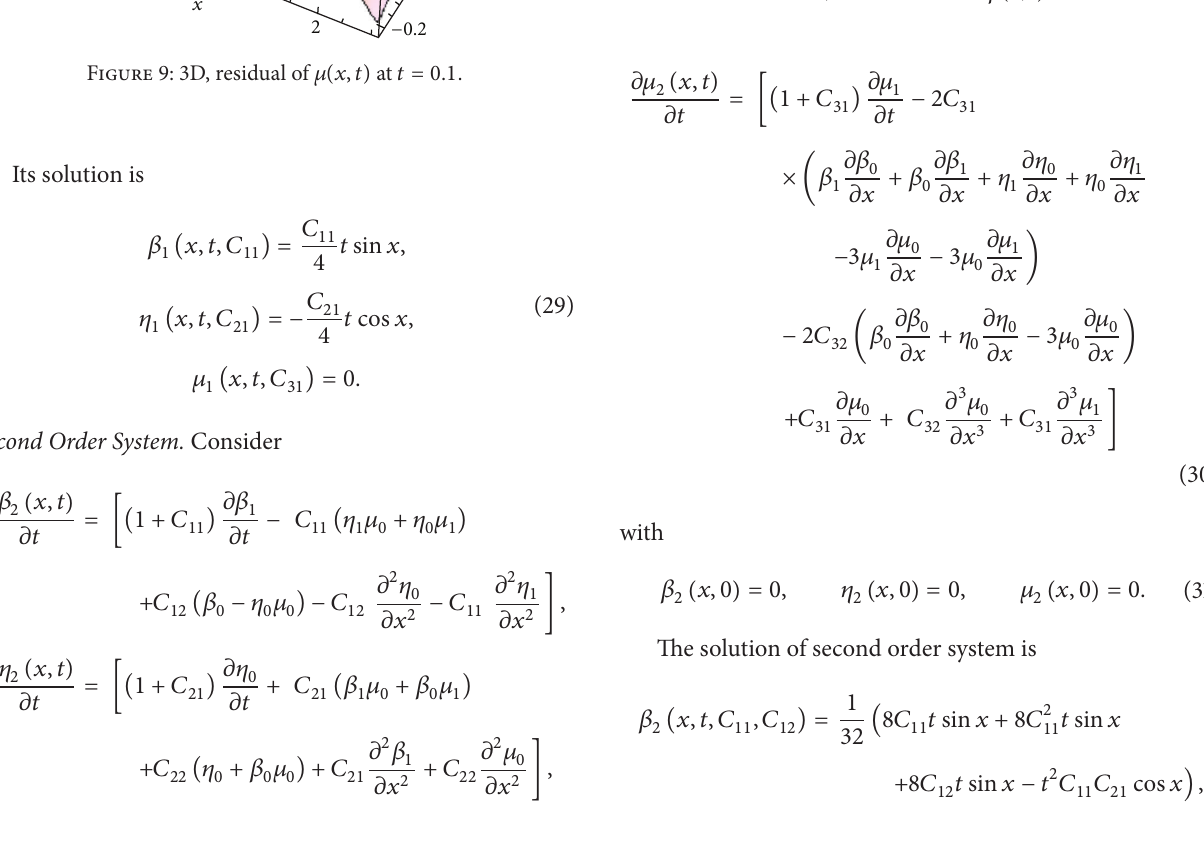
Figure 11: 2D, exact solution of 𝛽(𝑥,𝑡) at 𝑡 = 0.1